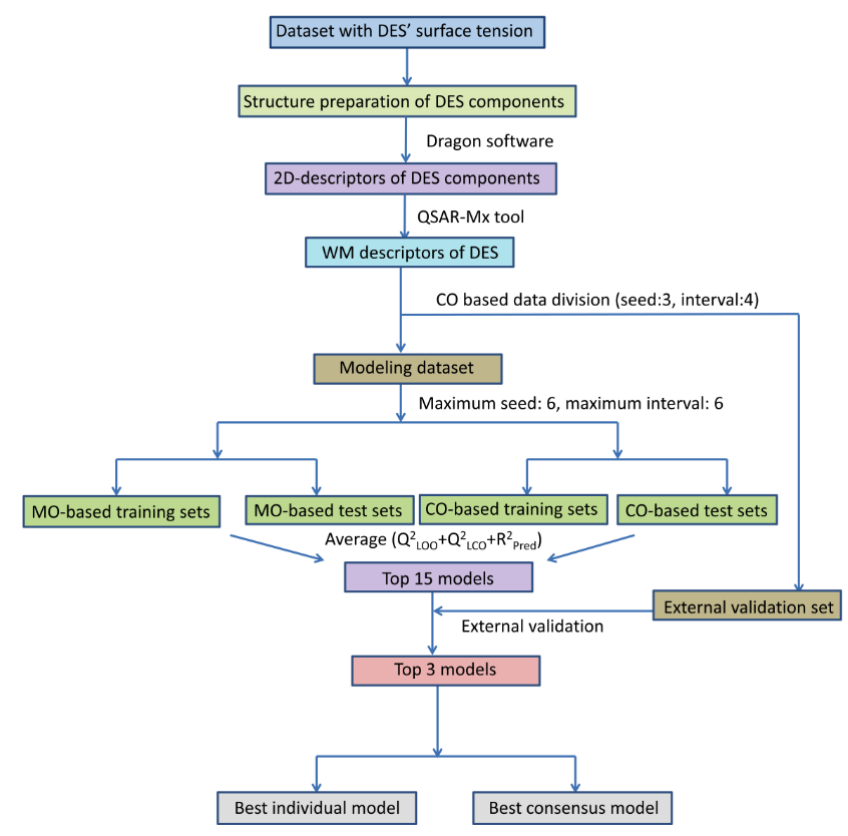
Figure 1. Basic workflow chart for the QSPR regression modeling, followed in this study.